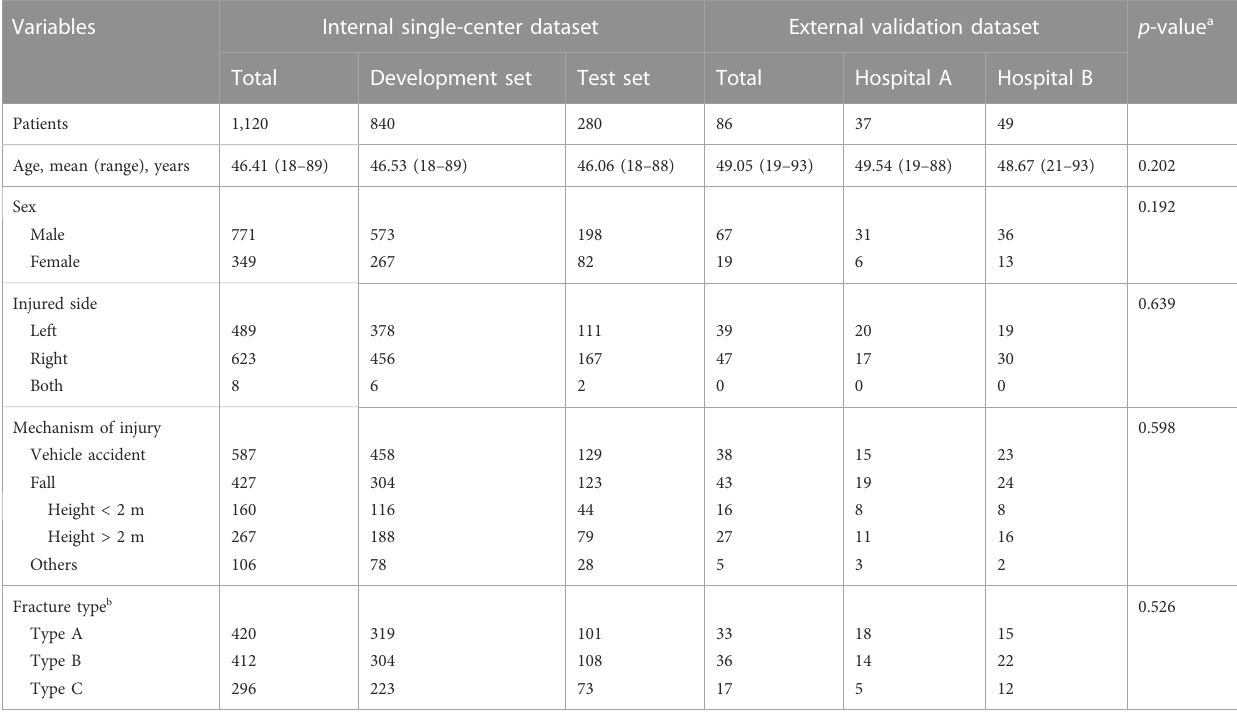
TABLE 1 Patient